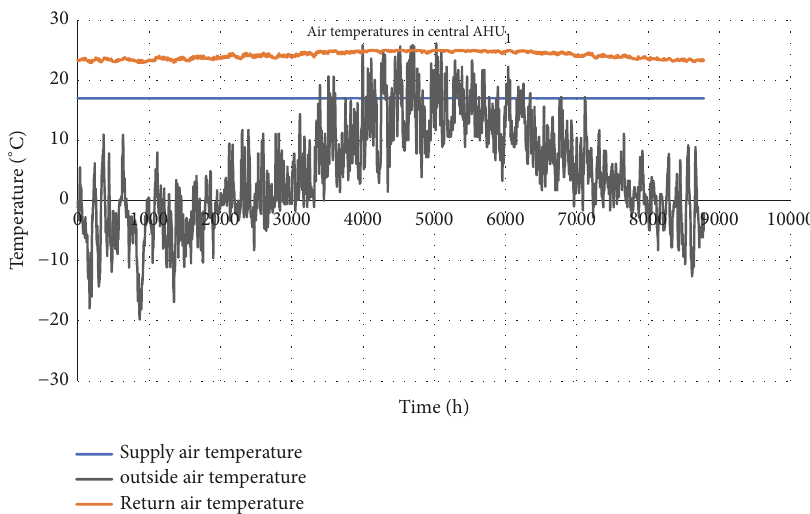
Figure 8: AHU 1 supply air, return air, and outdoor air